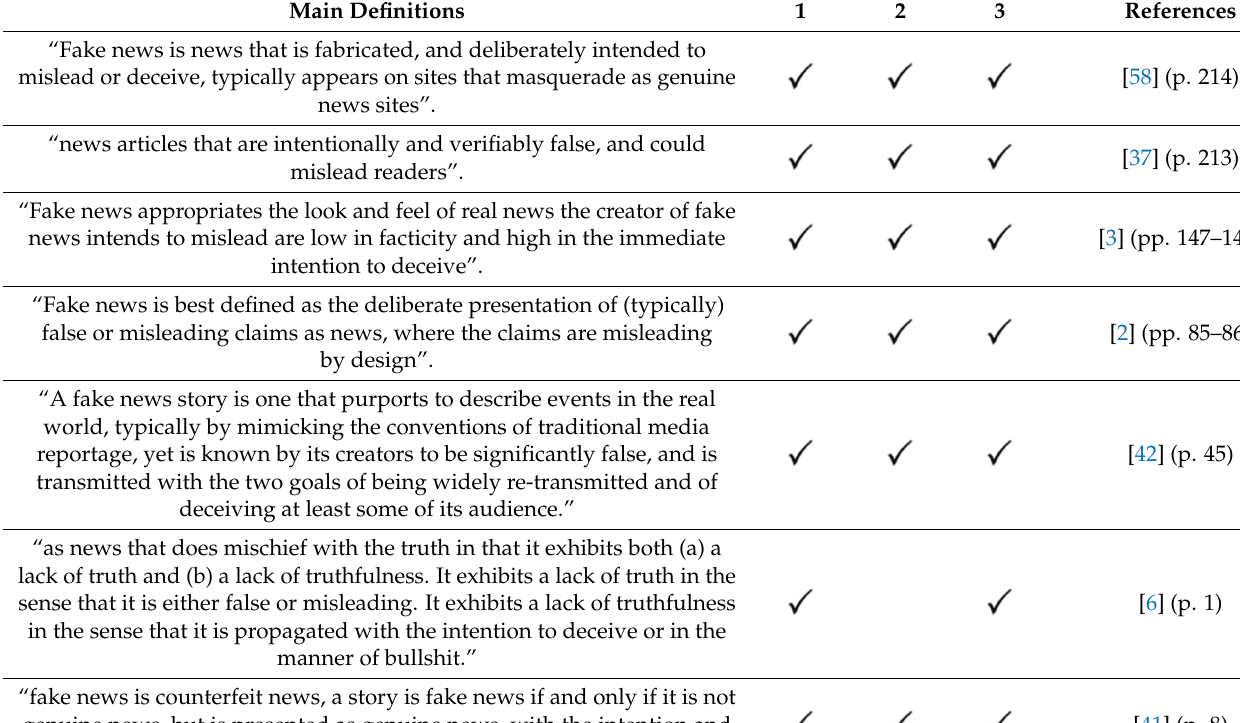
Table 1. Main proposals for the definition of fake news in the literature . Caption: (1) Completely or